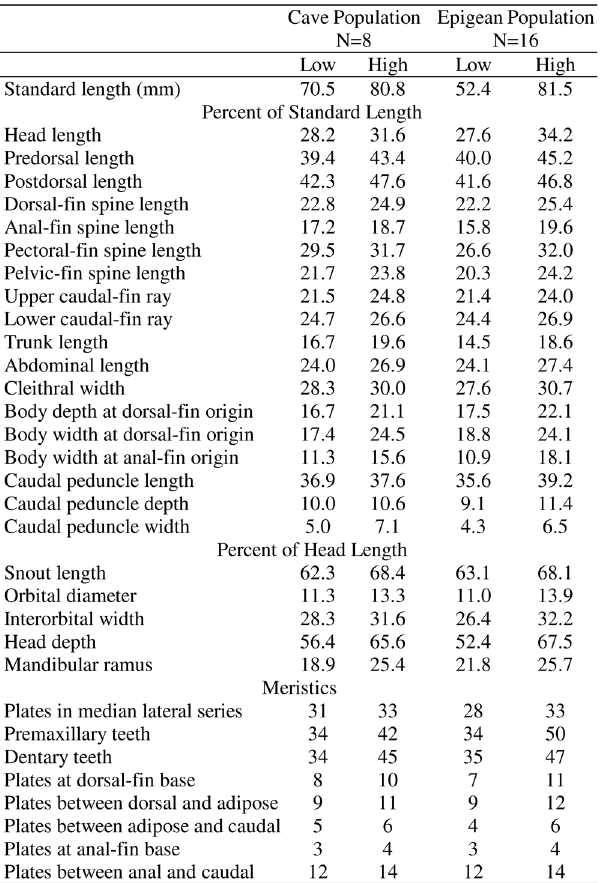
Table 1. Comparative morphometric and meristic data of cave and epigean populations of Isbrueckerichthys alipionis . Values are given as percent of standard length or head length. Data of epigean population includes holotype and